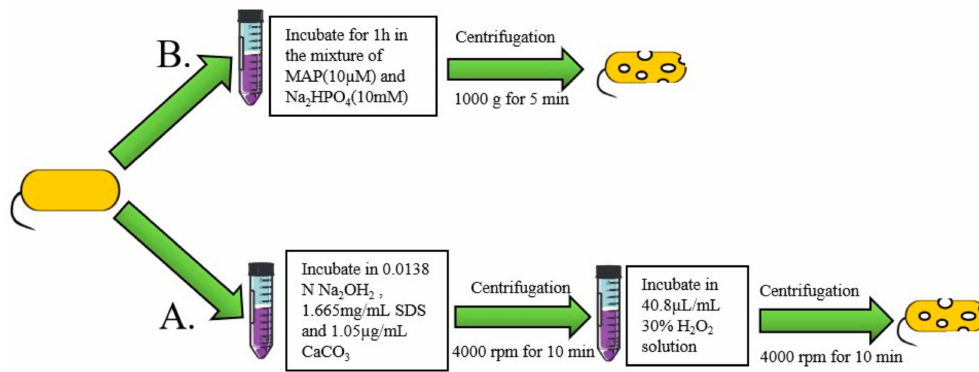
Figure 3. Chemical method for preparation of BGs. ( A ) Preparation of BGs using the model am- phiphilic peptide (MAP). ( B ) The two-step method for preparation of